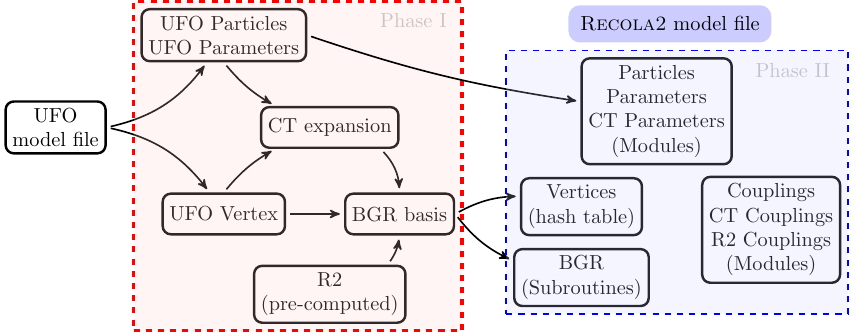
Figure 1. The RECOLA2 model-(cid:12)le generation. UFO vertices are taken as input and each vertex is permuted and mapped to a suited BGR operator. Given a counterterm expansion (2.4), REPT1L can generate all counterterm vertices and include them in the BGR. Once the renormalization is done and the R 2 -terms are computed, the model (cid:12)le is derived once again, including solutions to counterterm parameters and R 2